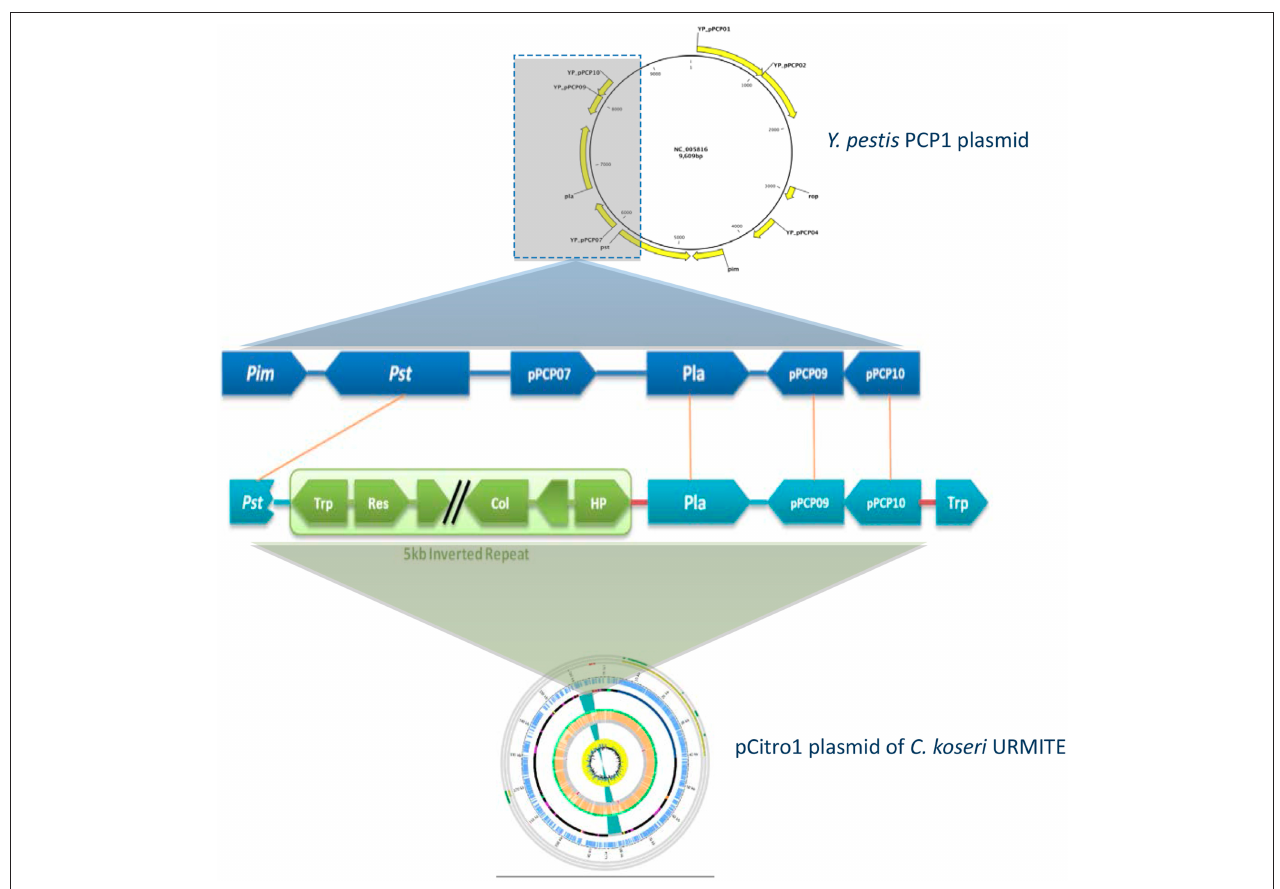
FIGURE 6 | Comparison of the pla region of Y. pestis pPCP1 with the pCitro1. The 9.6kb Y. pestis pPCP1 plasmid shows major similarity points with a pCitro1 region. The structural organization and the protein sequence identity ( > 99%) are highly conserved between pCitro1 and Y. pestis pPCP1 for Pla, PCP09 and PCP10 proteins. The PCP07 and the immunity Pim protein were not found in pCitro1. A fragment (54 amino acids) of the specific bacteriocin Pst protein is recovered downstream the 5kb inverted repeat of pCitro1. Trp, Res and HP indicate transposase, resolvase, and hypothetical proteins,